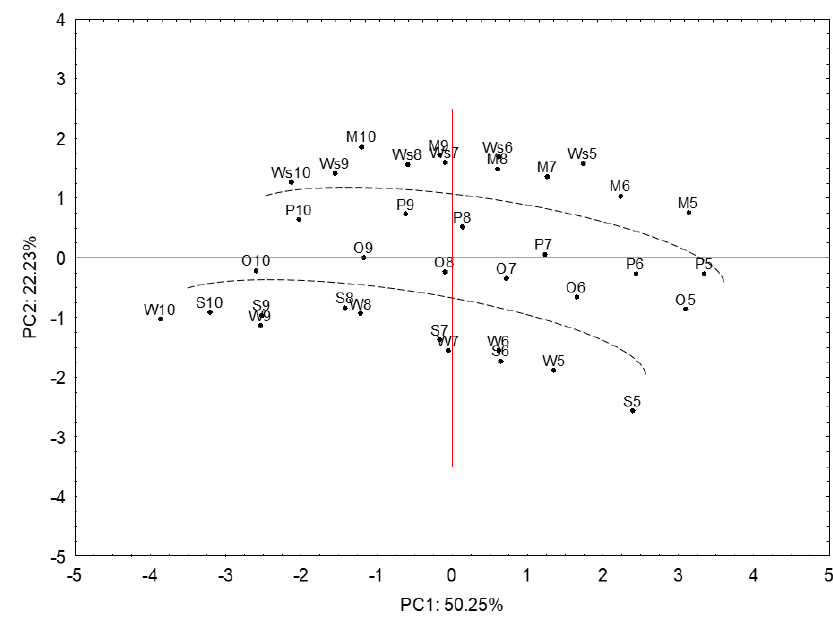
Figure 3. Observations at PC1 and PC2.